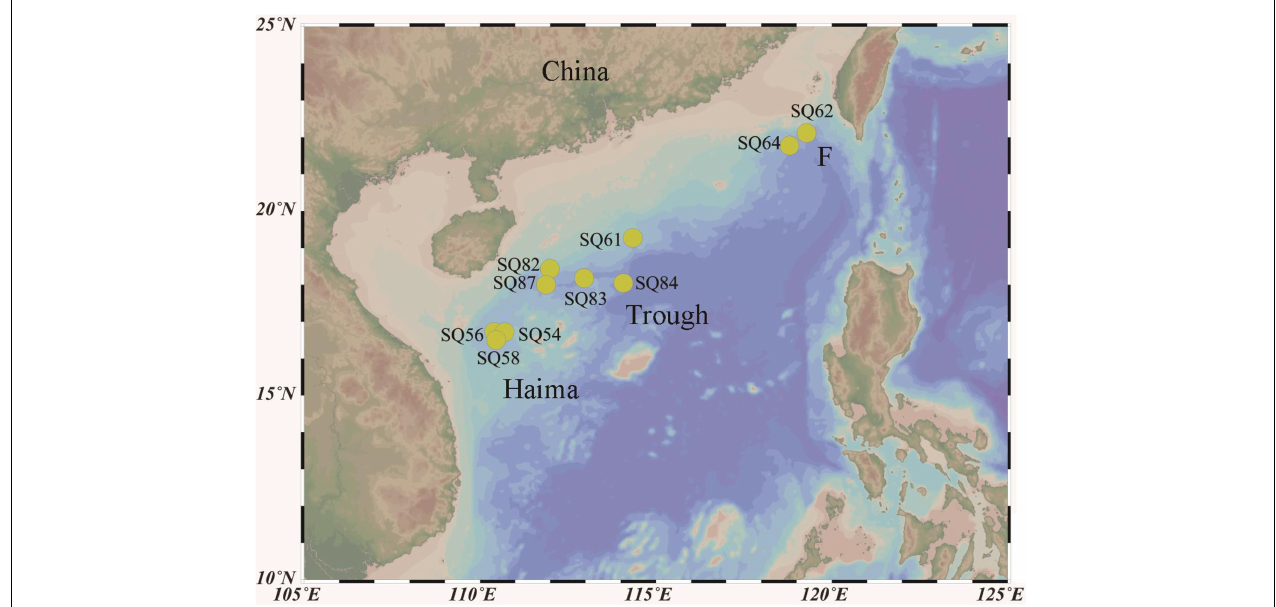
FIGURE 1 | Map of the sampling stations in the northern South China